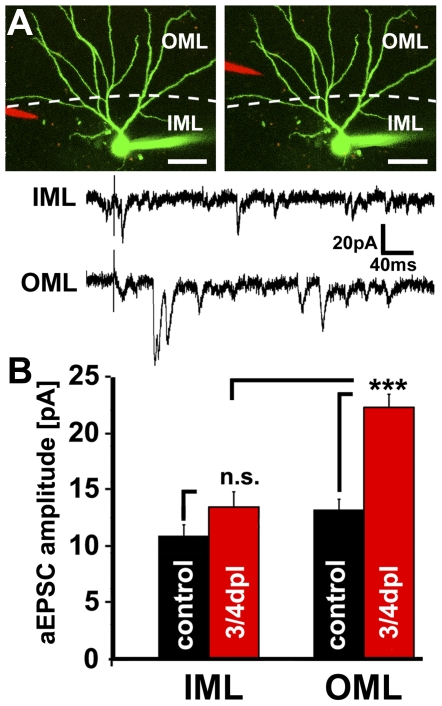
Electrically evoked asynchronous EPSCs confirmed layer-specific increase in excitatory synaptic strength.(A) Asynchronous EPSCs (aEPSC) were recorded from identified dentate granule cells in control and denervated cultures upon local electrical stimulation of the OML and IML (recordings performed in Sr2+-containing bath solution; red, pipette containing the stimulating electrode and Alexa568; green, patch-clamp electrode containing Alexa488). Scale bar: 40 µm. (B) An increase in mean aEPSC amplitude was observed in response to electrical stimulations of the OML but not in response to electrical stimulations of the IML of denervated dentate granule cells (n = 4 cultures each; 1–3 neurons per culture).